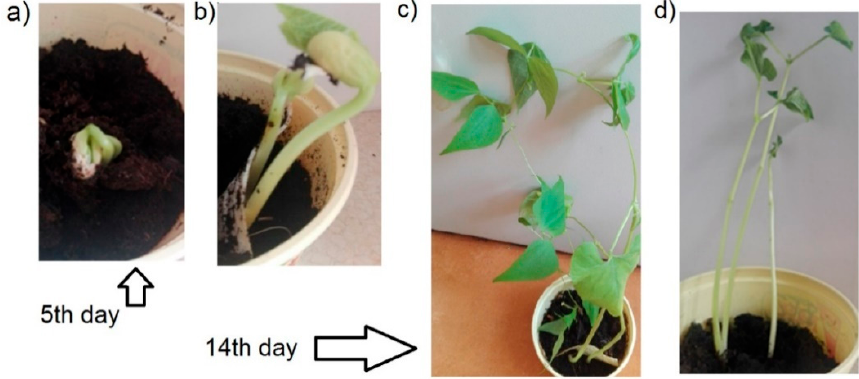
Figure 14. Growth of legume beans after 5 ( a , b ) and 14 ( c , d ) days from sowing.